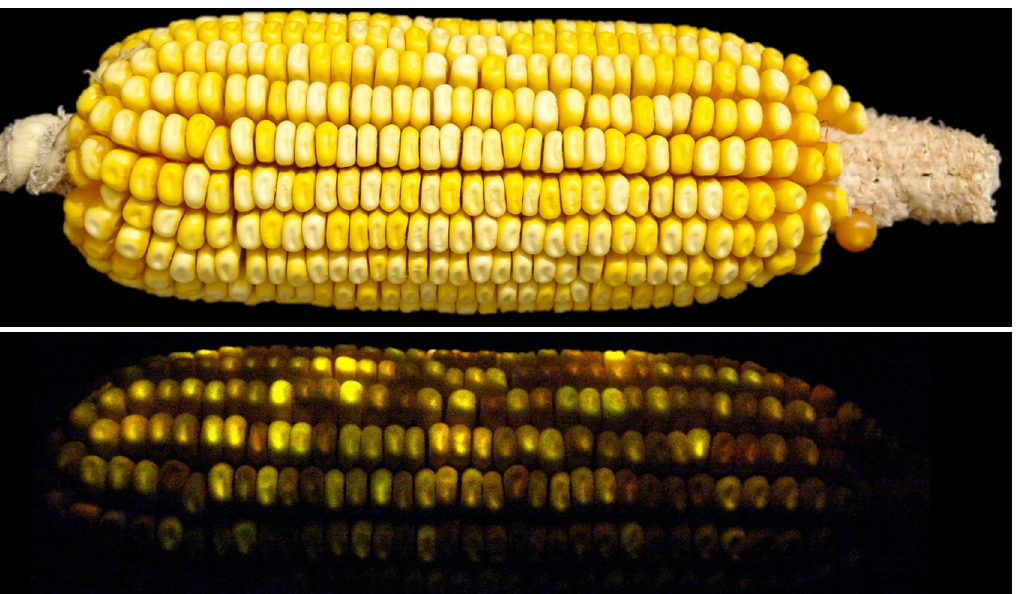
Fig 2. Maize segregating for various levels of GFP activity. The top panel is in white light and the bottom panel in blue light (485nm) with an orange filter (535nm).